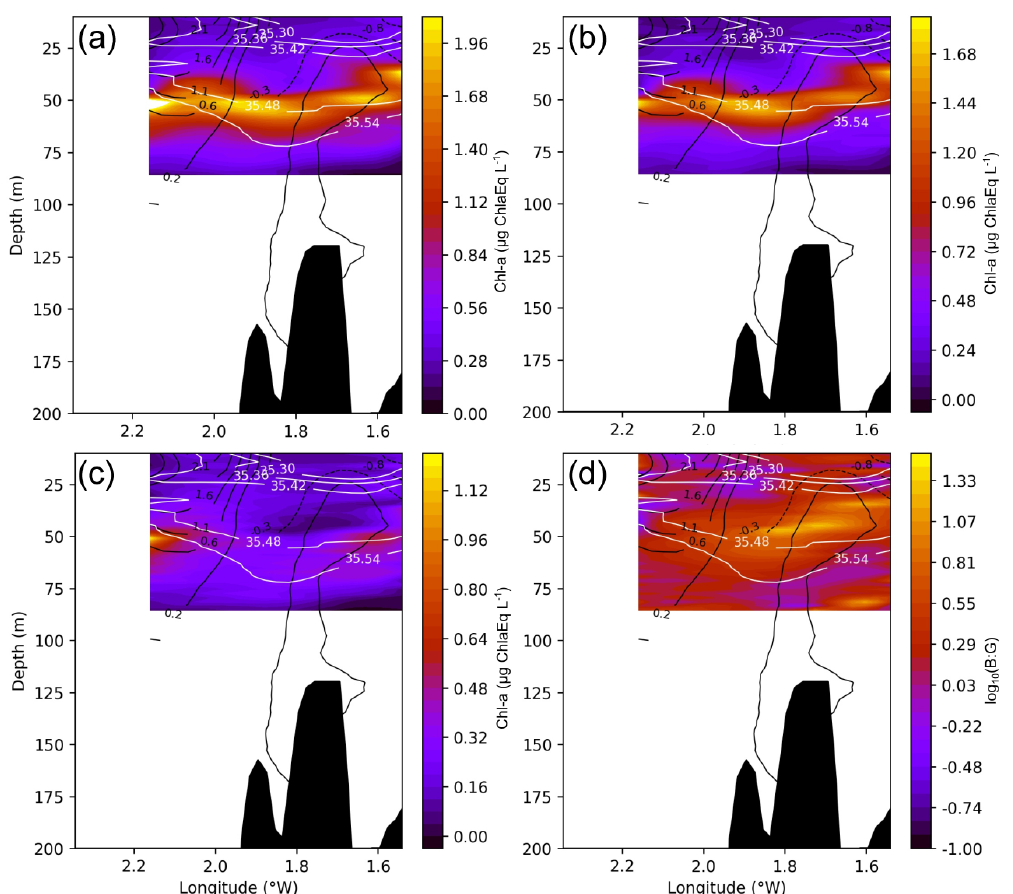
Figure A2. Cross section at 43.70 ◦ N of total chl a (a) , brown chl a (b) , green chl a (c) , and the brown : green (B : G) ratio logarithmically transformed (d) . White lines represent salinity contours and solid (dashed) black lines represent positive (negative) vorticity values or cyclonic (anticyclonic)